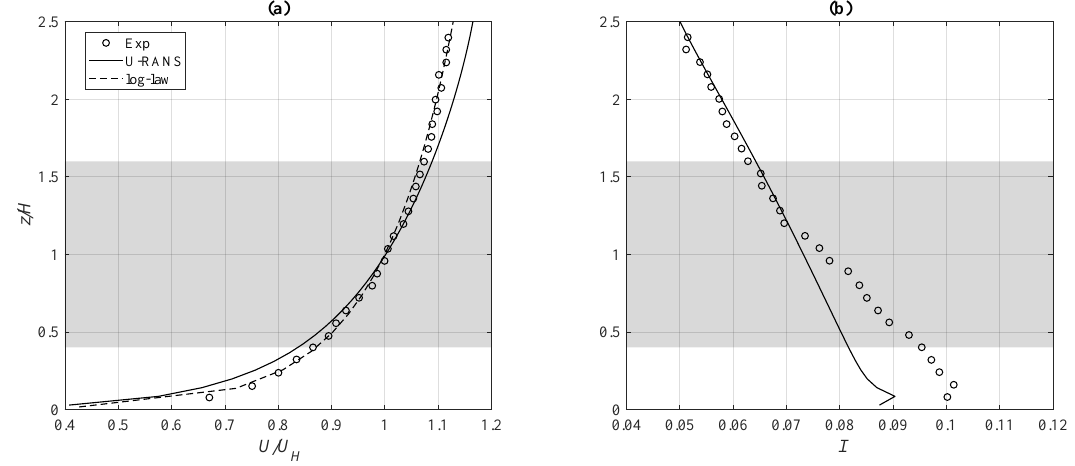
Figure 13. Vertical profiles of the upstream mean velocity ( a ) and TKE ( b ) from the midplane (the shaded region depicts the rotor area) [4].